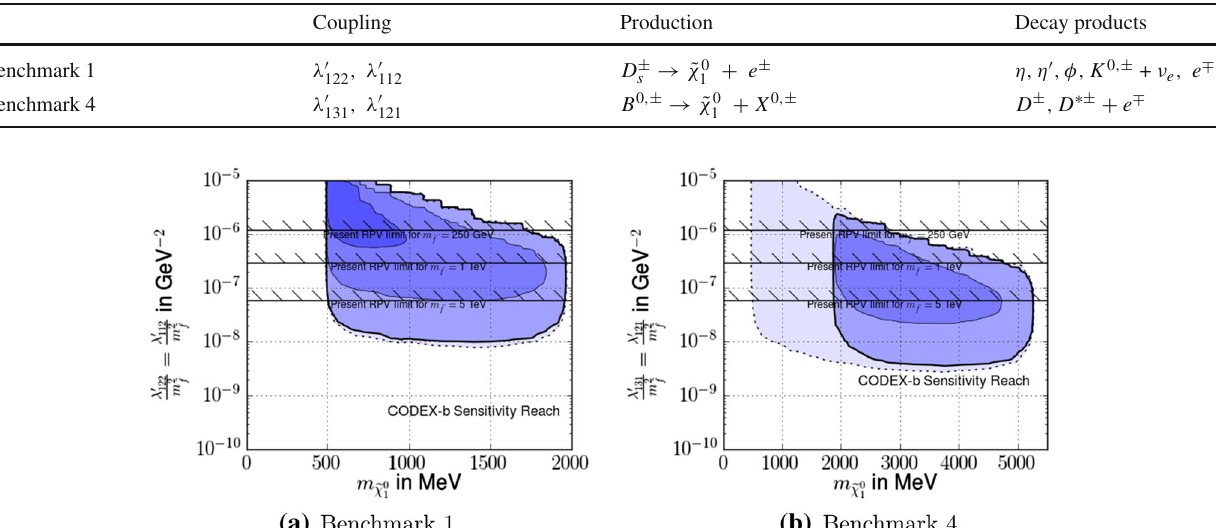
Fig. 15 Projected sensitivity of CODEX-b for light neutralinos with R-parity violating coupling produced in D and B meson decays, repro- duced from [107] with permission of the authors. The light blue, blue and dark blue regions enclosed by the solid black lines correspond to (cid:3) 3, 3 × 10 3 and 3 × 10 6 events respectively. The dashed curve rep-